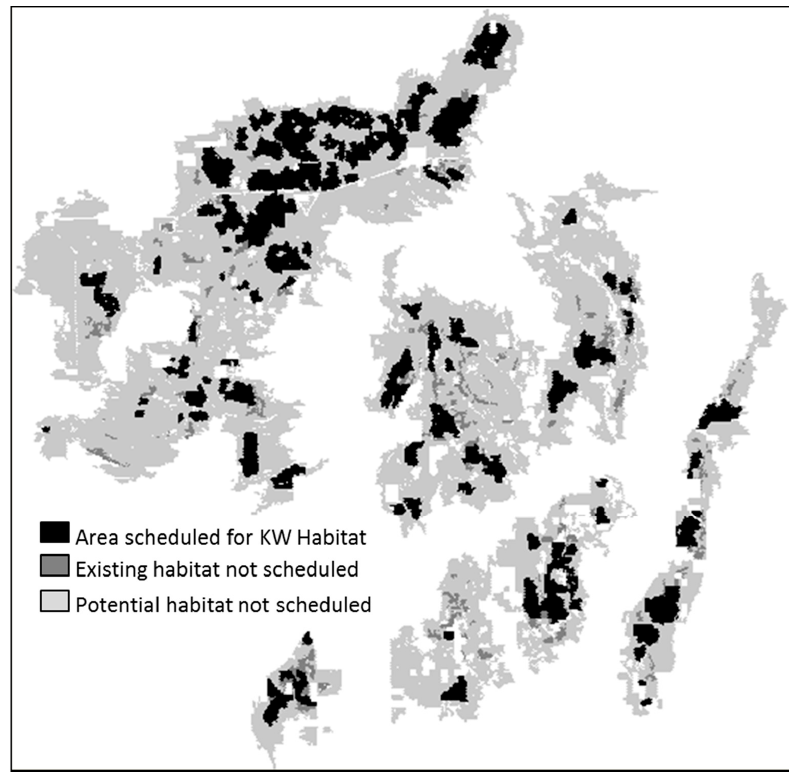
Figure 5. Core habitat areas scheduled in all time periods of the S3 2226 scenario (13,856 ha) and existing habitat not scheduled (2819 ha) for long-term persistence. This Figure represents the habitat potential of the four outwash plains of the Hiawatha National forest (Figure 1), rearranged spatially to better fit in the figure.